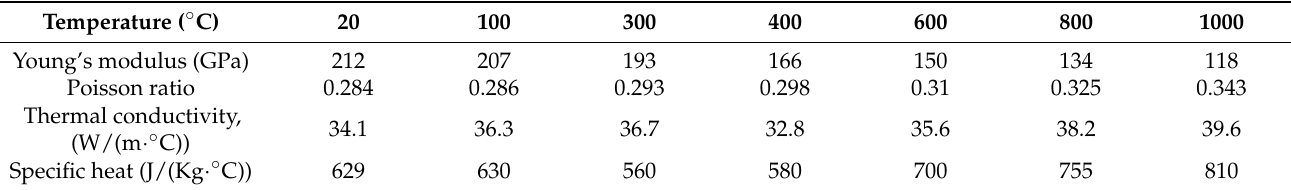
Figure 8. Temperature distribution of die surface and eight temperature measuring points of sheet. Figure 9 exhibits the temperature history curves for sheet at eight temperature meas- uring points under different quenching times of 10 s, 20 s, and 30 s. It can be seen from Figure 9 that the curves can be divided into four stages, namely transferring, forming, quenching, and cooling. In Figure 9, A represents the austenite zone, F represents the fer- rite transformation zone, B represents the bainite transformation zone, M represents the